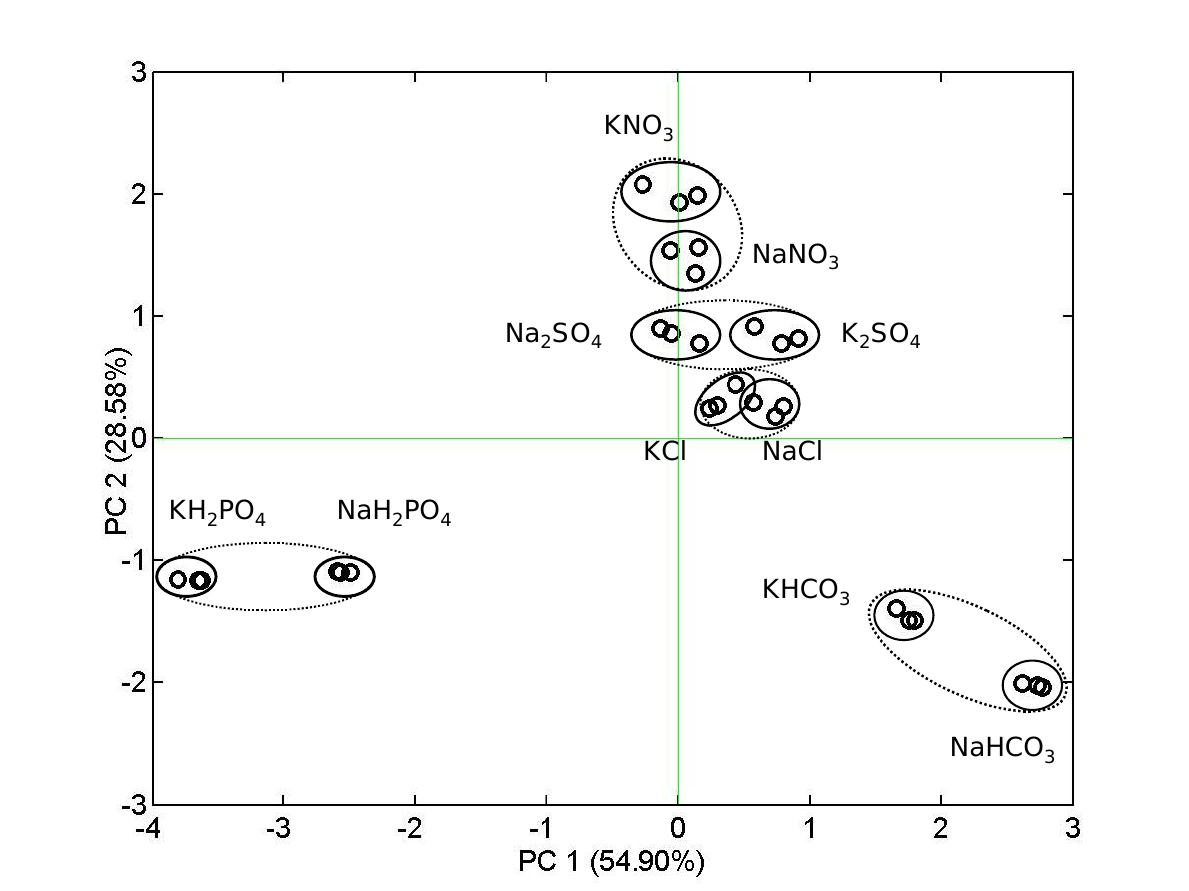
Figure 2. Principal component analysis (PCA) score plot for different aqueous solutions containing pure salts measured with a 6-electrode